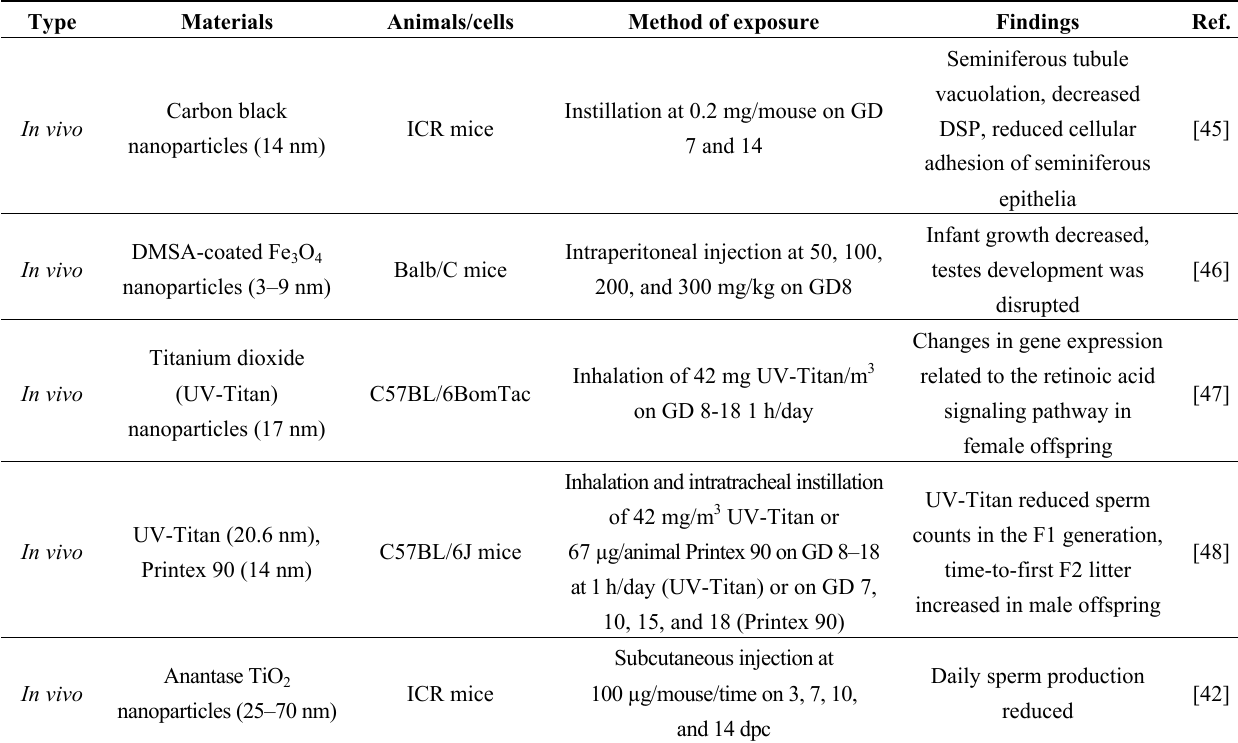
Table 4. Reproductive toxicity of nanoparticles to